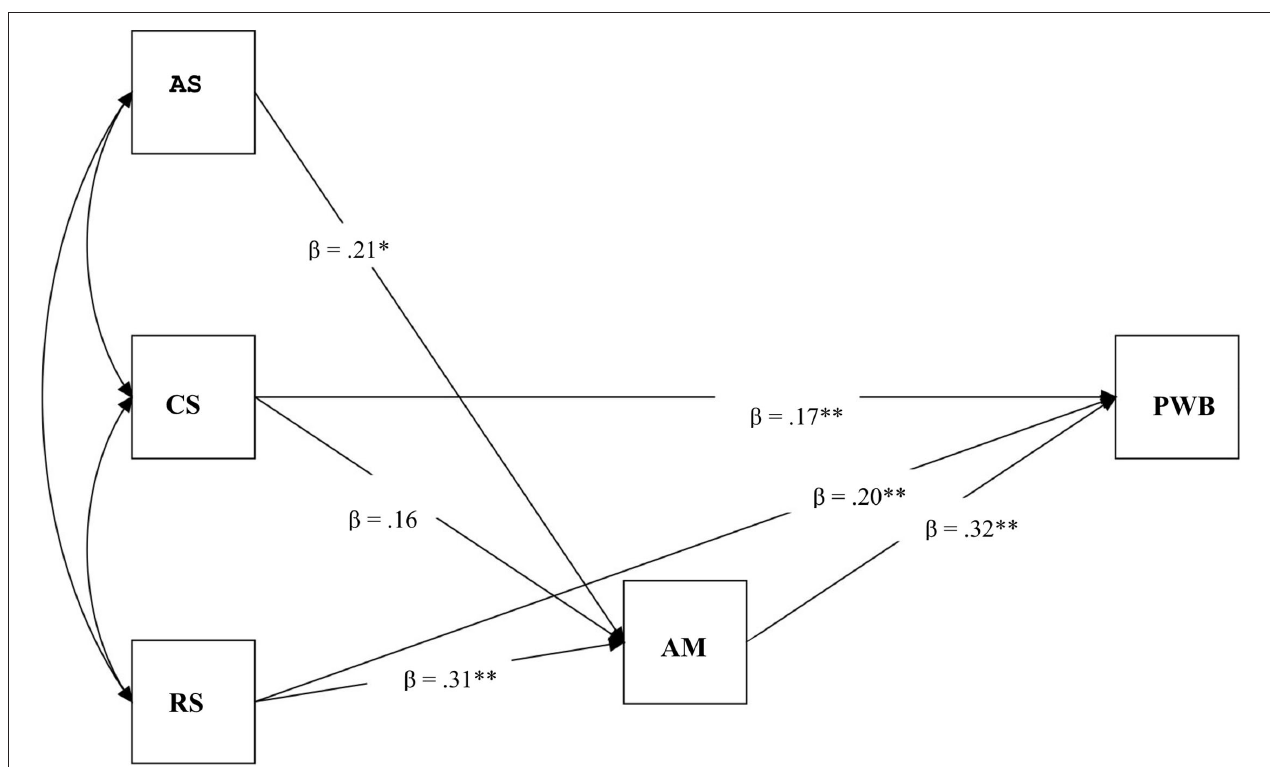
FIGURE 3 | The path between needs satisfaction, motivation and PWB for the elderly French. X 2 /df = 1.489, p = 0.136, RMSEA = 0.054, CFI = 0.970, TLI = 0.925, SRMR = 0.022. AS, autonomy satisfaction; CS, competence satisfaction; RS, relatedness satisfaction; AM, autonomous motivation. * p < 0.05, ** p < 0.01.